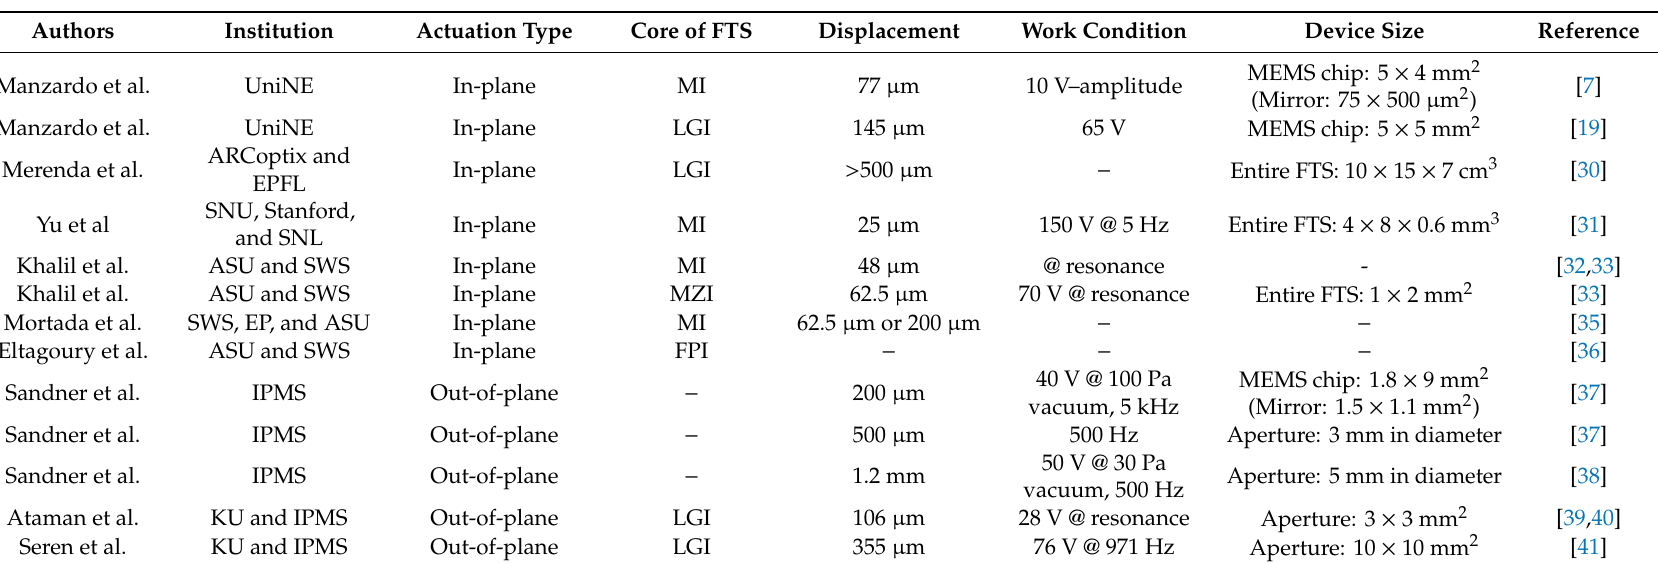
Table 1. Comparison of electrostatic micro-electromechanical system (MEMS) micromirrors and Fourier transform spectrometers